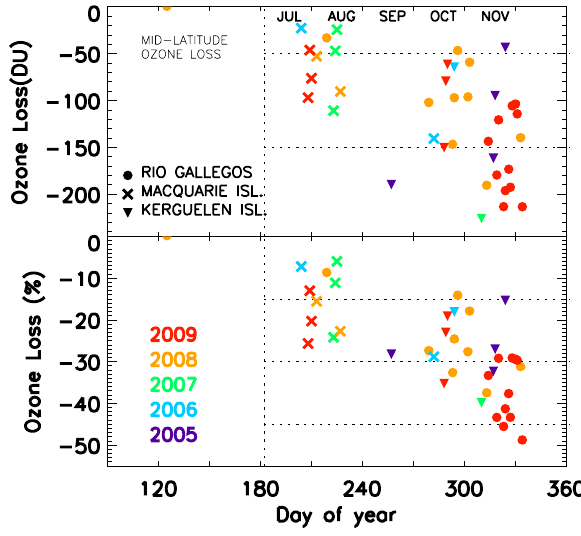
Fig. 9. Ozone loss estimated during the vortex events at selected southern mid-latitude stations for the recent Antarctic winters (Top: DU, bottom: percent). The loss in absolute unit (DU) is esti- mated as ozone meas -tracer and its relative loss (%) is computed as 100 × (ozone meas -tracer)/tracer. The dotted vertical line represents July 1, and the horizontal lines show 50 and 150DU and 15, 30 and 45% of ozone